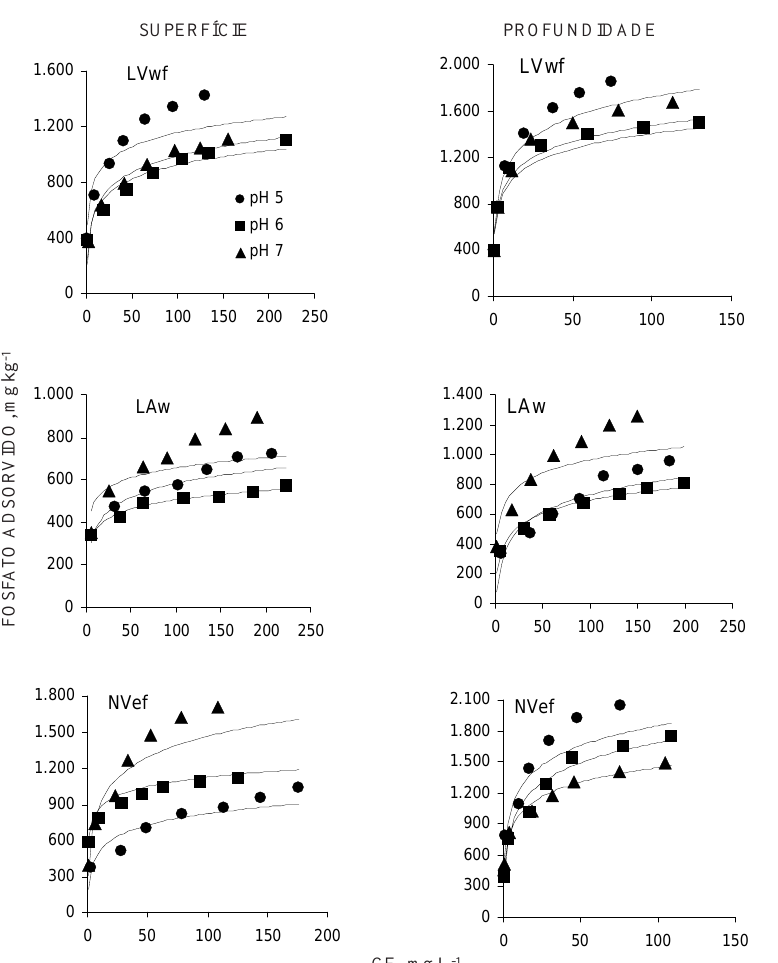
Figura 2. Adsorção de fosfato determinada (marcadores) e simulada pelo modelo tetraplanar (linhas) em função da concentração de equilíbrio (CE), para diferentes valores de pH para o Latossolo Vermelho ácriférrico (LVwf), Latossolo Amarelo ácrico (LAw) e Nitossolo Vermelho eutroférrico